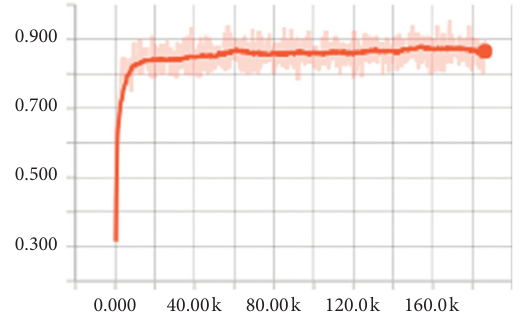
Figure 4: Changes in the accuracy rate of Farmer 1 model.